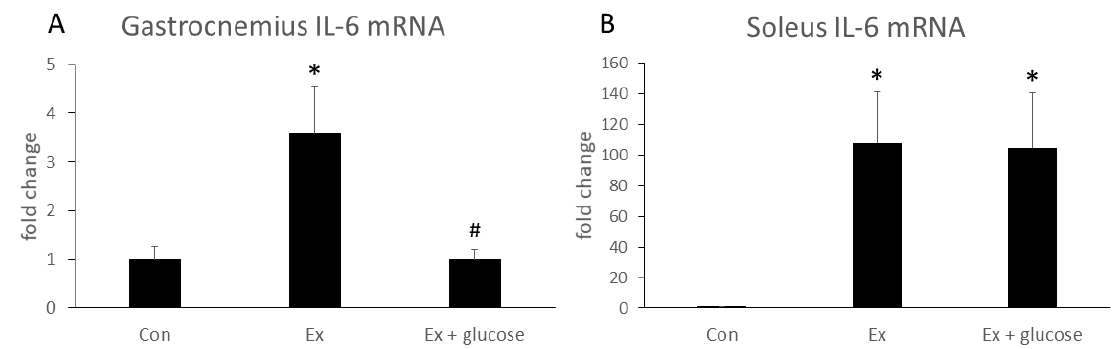
Figure 2. Effects of exercise and glucose ingestion on IL-6 mRNA expression in ( A ) gastrocnemius and ( B ) soleus. The data are presented as the fold change ± SE, relative to the values from the Con. * p < 0.05 compared to Con. # p < 0.05, compared to Ex.